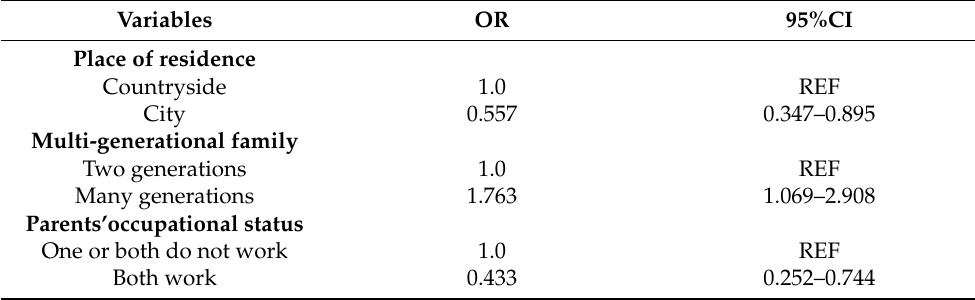
Table 5. Potential predictors of use of supplements in studied